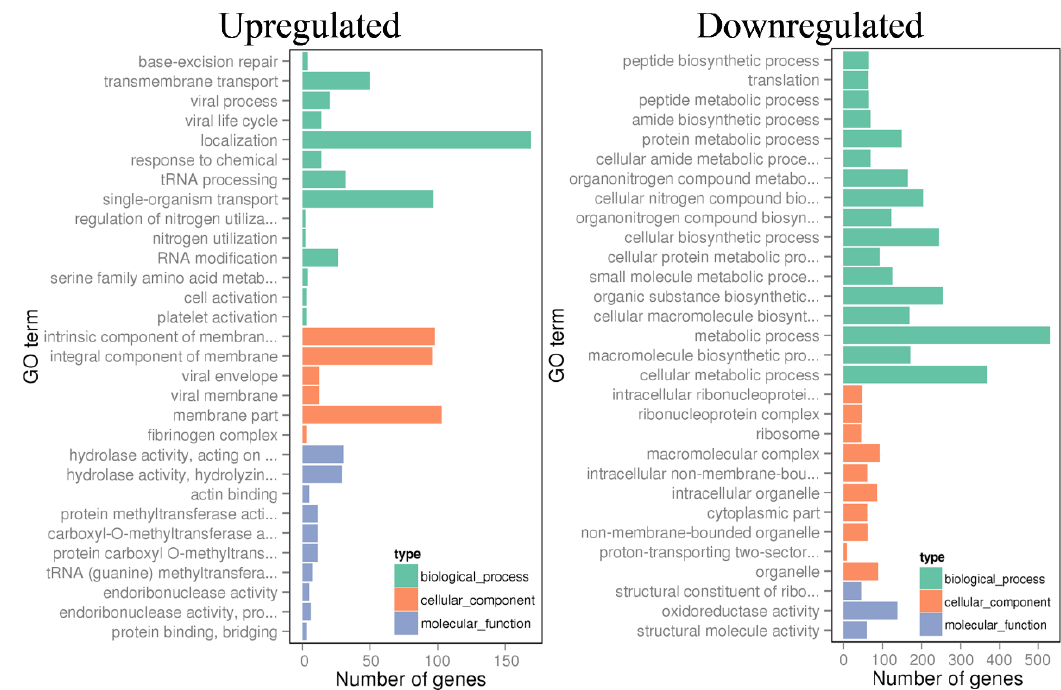
Figure 4. GO Enrichment analysis of the up- and downregulated gene pools of strain RA cultivated on beechwood xylan. 256